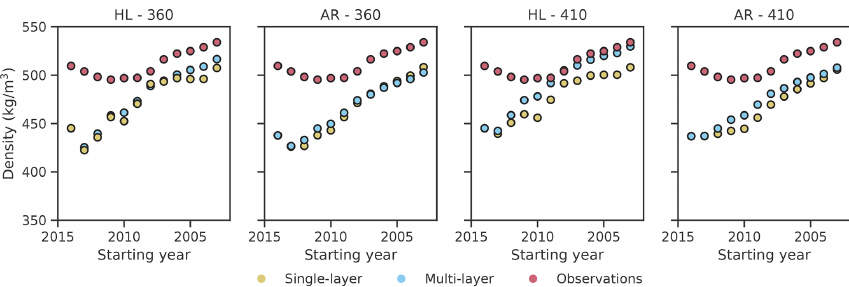
Figure 9. Average firn density of CG15 ice core observed and obtained with the single-layer version of the model or averaging the density of each individual firn layer obtained with the multi-layer version, weighted for their heights. Each point corresponds to a run of the model whose starting date is reported on the x axis. The ending year for all runs is 30 September 2015. AR and HL stand for the model versions with Arnaud et al. (2000) and Herron and Langway (1980) implemented, respectively. The values 360 and 410 stand for the chosen value of ρ D .